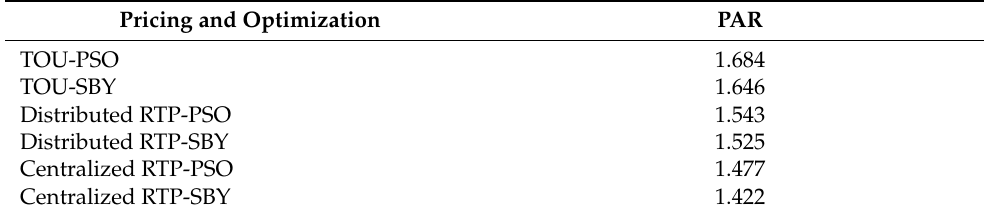
Table 10. PAR calculation for the commercial load.